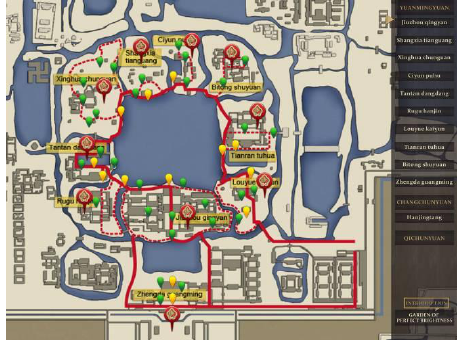
Figure 7: Digital navigation equipment collects tourist information and feeds it back to backstage